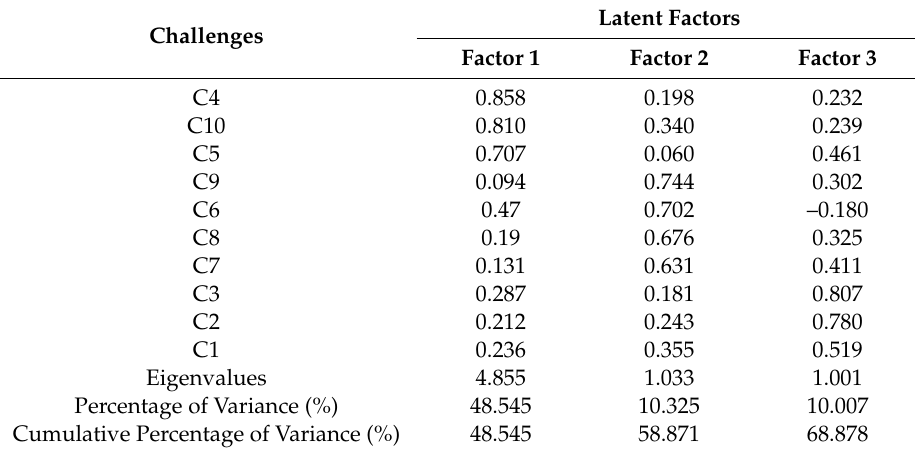
Table 9. Factor analysis on challenge